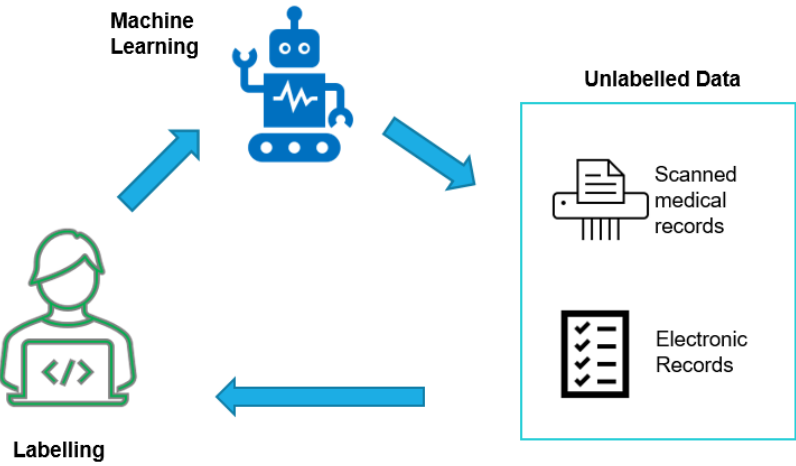
Figure 1. An overview of supervised machine learning using in active learning (AL). 79